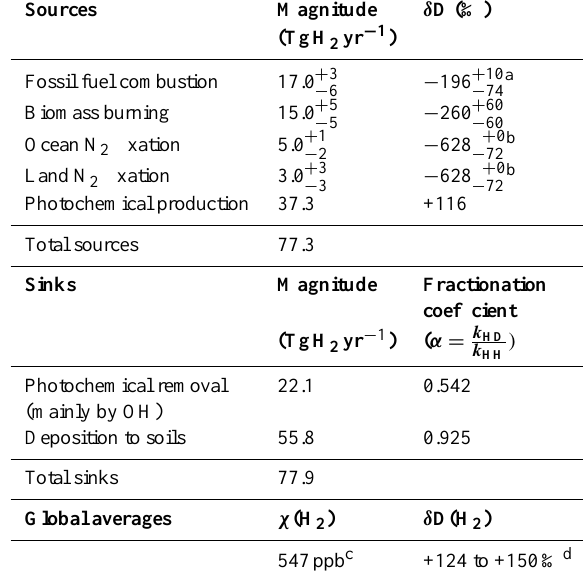
Table 1. The global H 2 budget and isotope budget as estimated by Pieterse et al. (2011) in a model study with global model TM5. The estimated magnitudes, isotopic signatures and uncertainties (super- and subscript numbers) of the different surface sources were based on previous studies. For biomass burning, the estimated source sig- nature was based on measurements that were later published in R¨ockmann et al. (2010a). The magnitudes and isotope effects of the photochemical processes and the soil uptake were calculated from the model output; in this first H 2 study with TM5, no estimates of the uncertainties associated with these terms were made yet. At the bottom of the table are estimates by different authors of the global average χ (H 2 ) and δ D(H 2